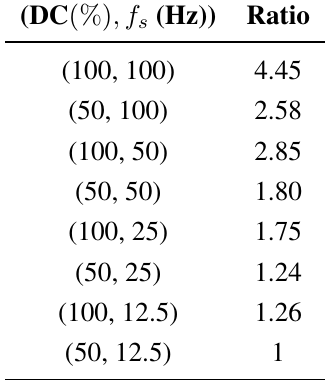
Table 2. The power consumption ratio in the sensor drain per each operation cycle: t and the comparison applied based on (50%, 12.5